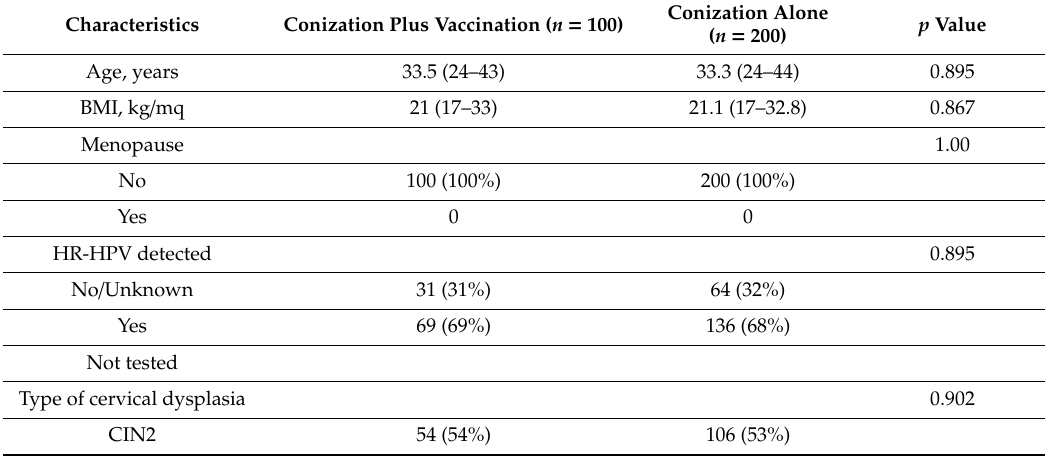
Table 2. Baseline characteristics of the population included in the propensity score